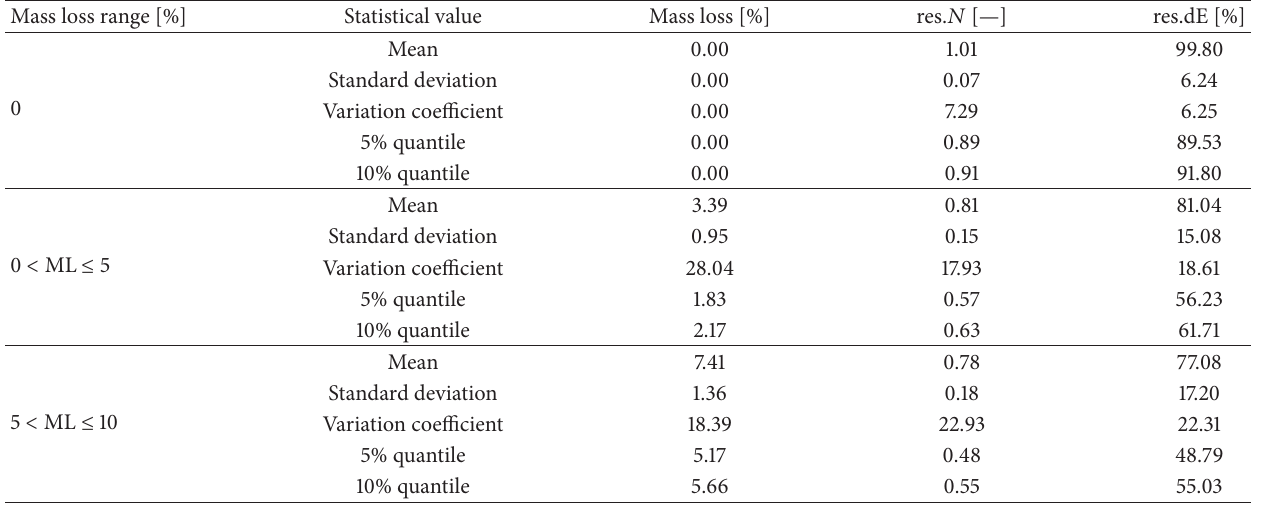
Table 6: Evaluation of quantile values.